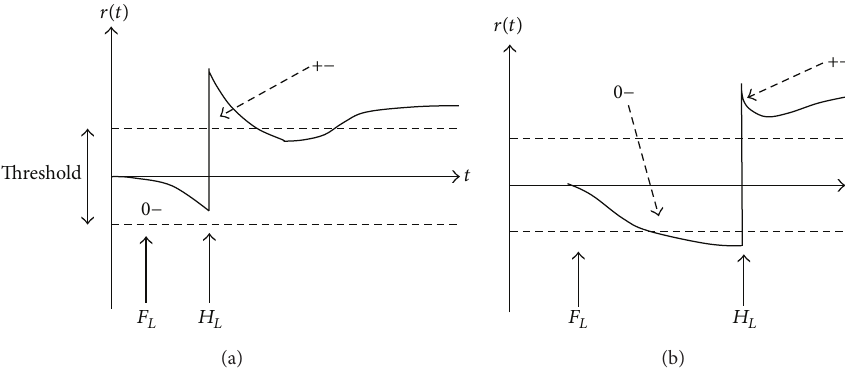
Figure 1: (a) 𝐻 𝐿 occurs close enough to 𝐹 𝐿 ; (b) 𝐻 𝐿 occurs after 𝐹 𝐿 ( 0− and 0+ represent that the value of parameter decreases and increases; ± represents that the value is first increased and then